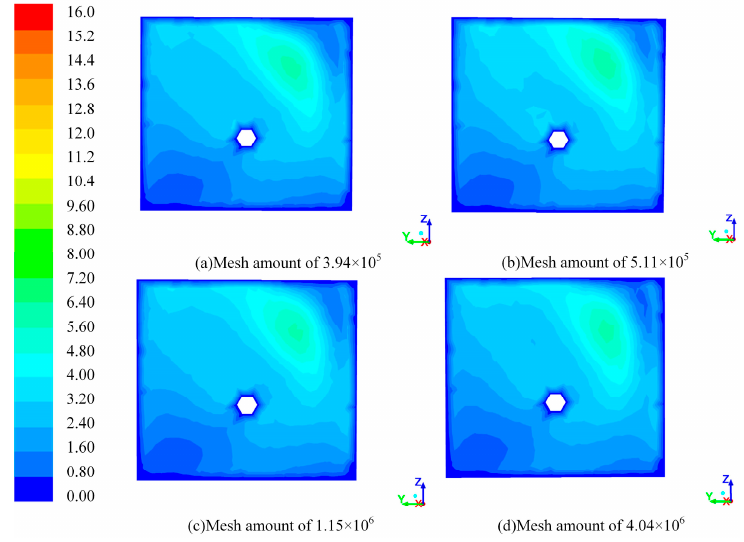
Figure 2. Velocity field of the airflow (m/s) under different mesh generation.